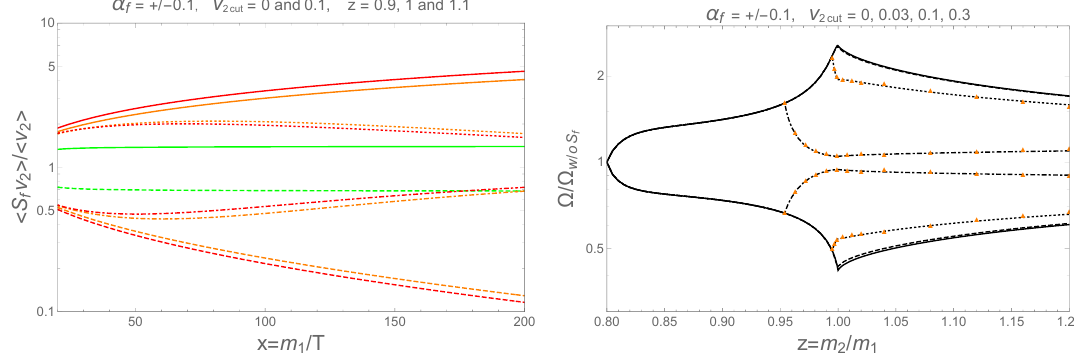
Figure 3 . Left panel: the ratio of the thermally averaged cross sections with and without the FSS effect as a function of x = m 1 /T , for z = 0 . 9 (green lines), 1 (orange lines) and 1 . 1 (red lines). The lines above (below) h S f v 2 i / h v 2 i = 1 are for α f = 0 . 1 ( − 0 . 1) . The solid and dashed lines are for v 2cut = 0 , while the dotted and dash-dotted lines are for v 2cut = 0 . 1 . Right panel: the ratio of DM relic densities with and without the FSS effect computed from eq. (2.14), as a function of z = m 2 /m 1 . The solid, dashed, dotted and dash-dotted lines are for v 2cut = 0 , 0 . 03 , 0 . 1 and 0 . 3 , respectively. The lines above (below) Ω / Ω = 1 are for α f = − 0 . 1 (0 . 1) . In all lines x fo , n = 25 w / oS f is used. The orange triangles are ratios calculated directly from eq. (2.7) by imposing v 2cut = 0 . 1 (for marks located near the dotted lines) or 0 . 3 (for marks located near the dash-dotted lines), using ( a 0 / GeV − 2 , m 1 / GeV) = (10 − 7 , 10 4 ) for 1 . 04 ≤ z ≤ 1 . 2 , and (10 − 9 , 10 4 ) for the rest.